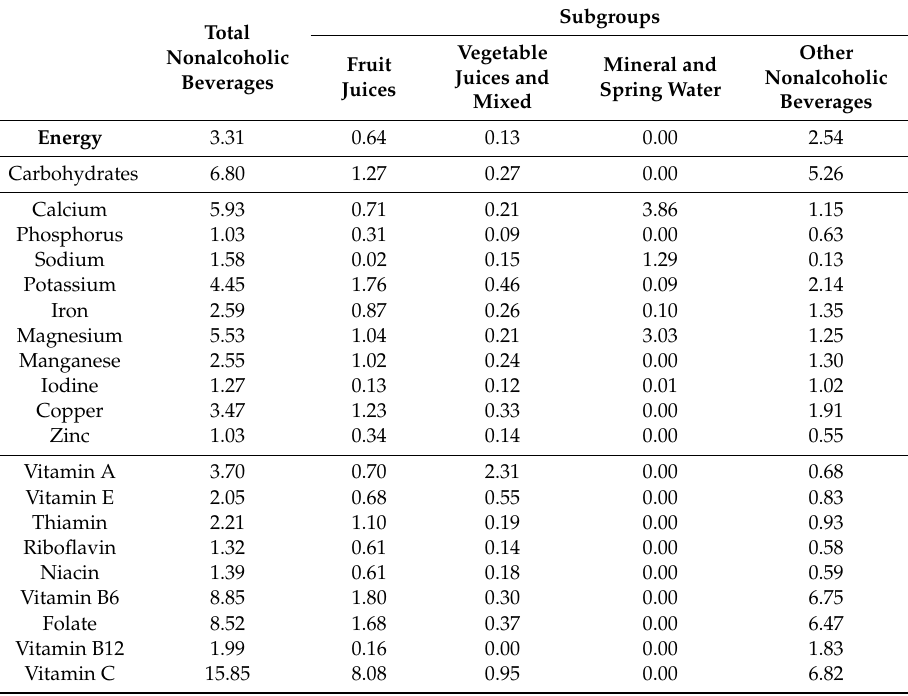
Table 1. Energy and nutrients supplied by nonalcoholic beverages in the average Polish diet (in